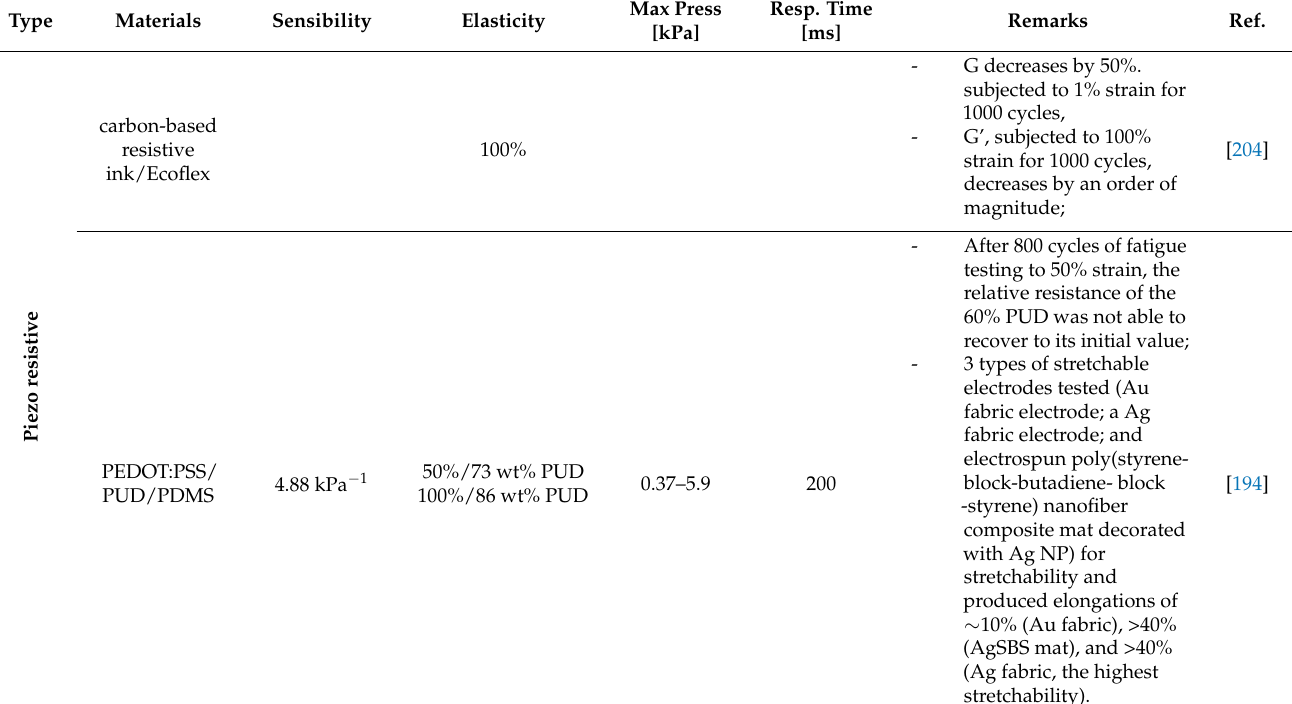
Table 2. Summary of strain/pressure e-skin